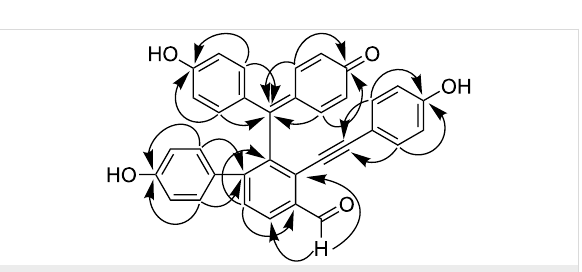
Figure 2: Key HMBC correlations of compound 1